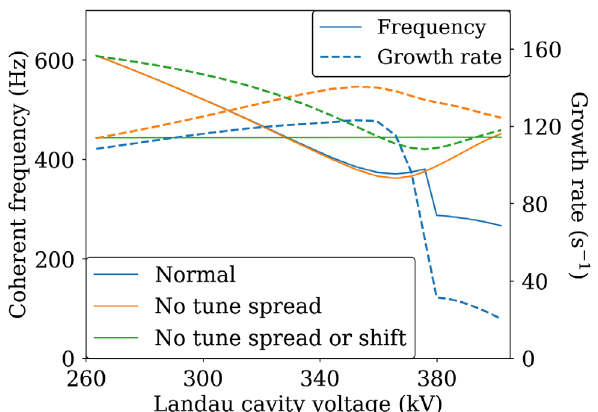
FIG. 14. Growth rates and coherent frequencies of coupled- bunch modes driven by two HOMs detuned in opposite directions from the nearest revolution harmonic. The impact of two effects are investigated. First, the tune spread is removed by setting the tune of each bunch to the average value h ω s ; l i . Second, the tune shift due to the increased fields in the Landau cavities is removed by setting the tune of each bunch to the average value for all bunches and all Landau cavity fields in the figure. The cases are otherwise